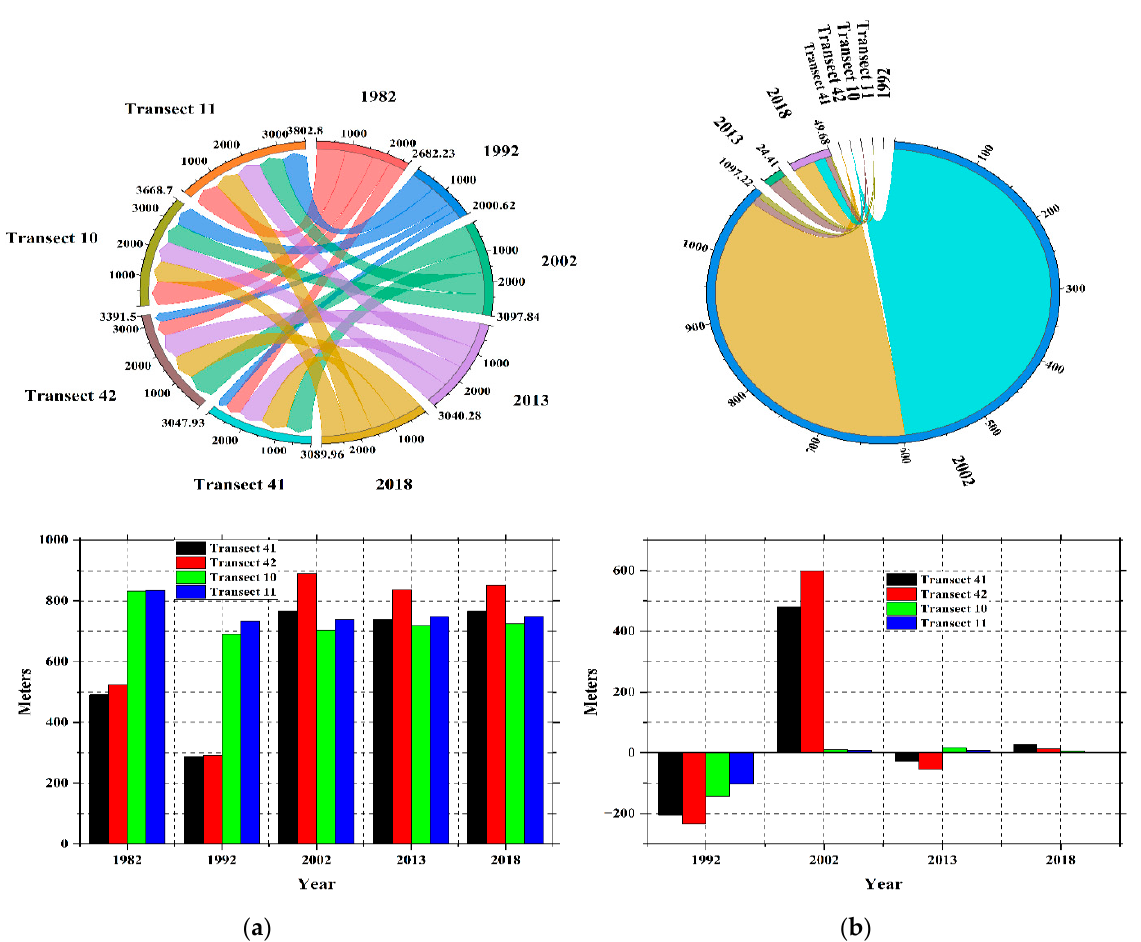
Figure 14. ( a ) Distance from baseline (m), ( b ) shoreline gain/loss in comparison to the last timeline (m).